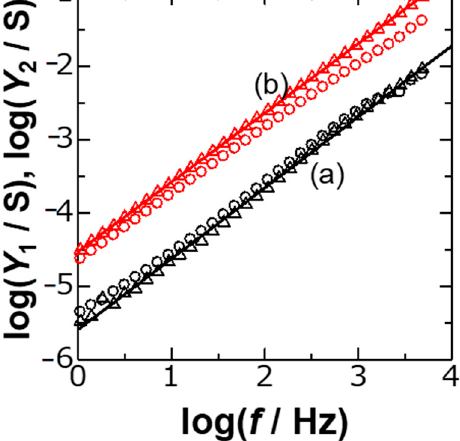
Figure 2. Dependence of ( a ) log Y 1 and ( b ) log Y 2 on log f in the solution of (circles) 0.05 M and (tri- angles) 5 M KCl solution at E dc = 0.0 V vs. Ag|AgCl. (triangles) 5 M KCl solution at E dc = 0.0 V vs.